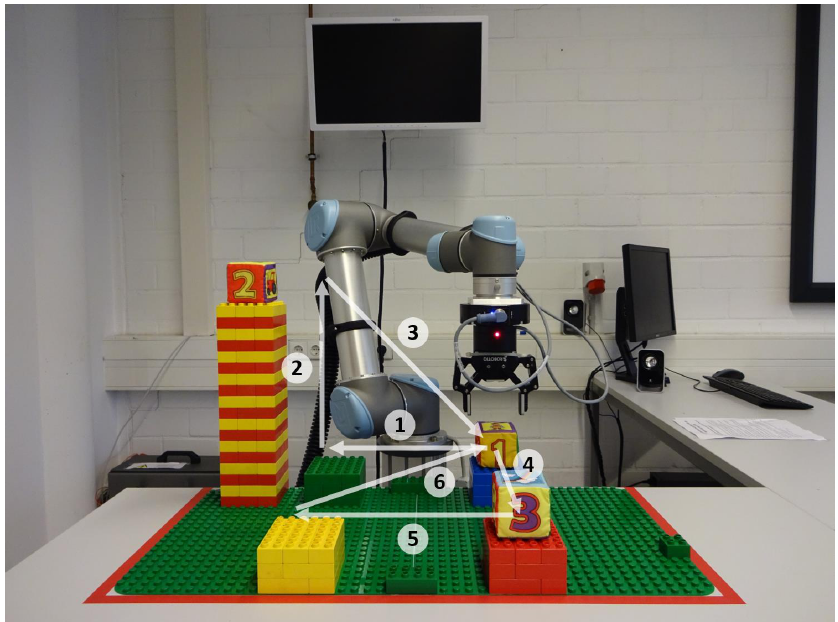
Figure 9. Experimental setup of the predefined task. The subjects were clearly instructed how to move the robot. Movements 1–3 had to be performed in the Vertical Plane group, movements 4–6 in the Horizontal Plane group. After movement 6, the subjects had to perform one 90 ◦ -rotation around each rotation